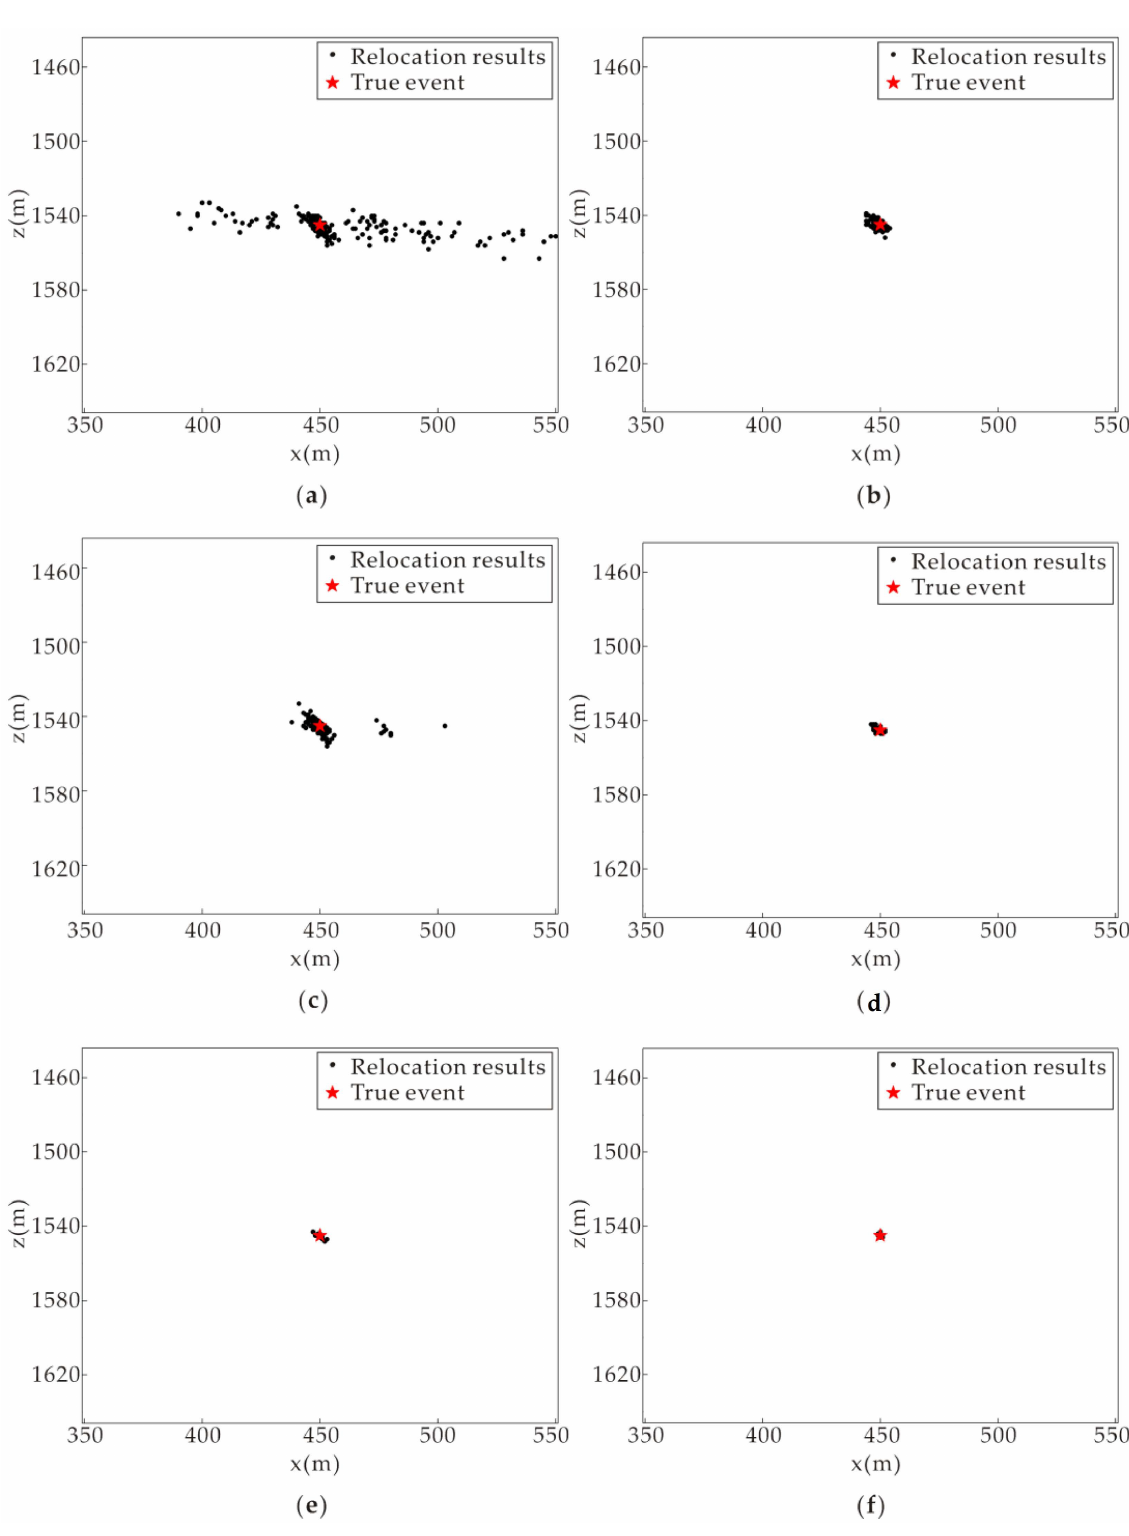
Figure 5. Relocation results obtained by applying the conventional ( a , c , e ) and improved ( b , d , f ) polarity correction methods through the utilization of the same corresponding 200 realizations as in Figure 4, respectively. The black dots and red pentagram denote relocation results and the true location of the target event, respectively. SNR is ( a , b ) 0.15, ( c , d ) 0.25 and ( e , f ) 0.5,